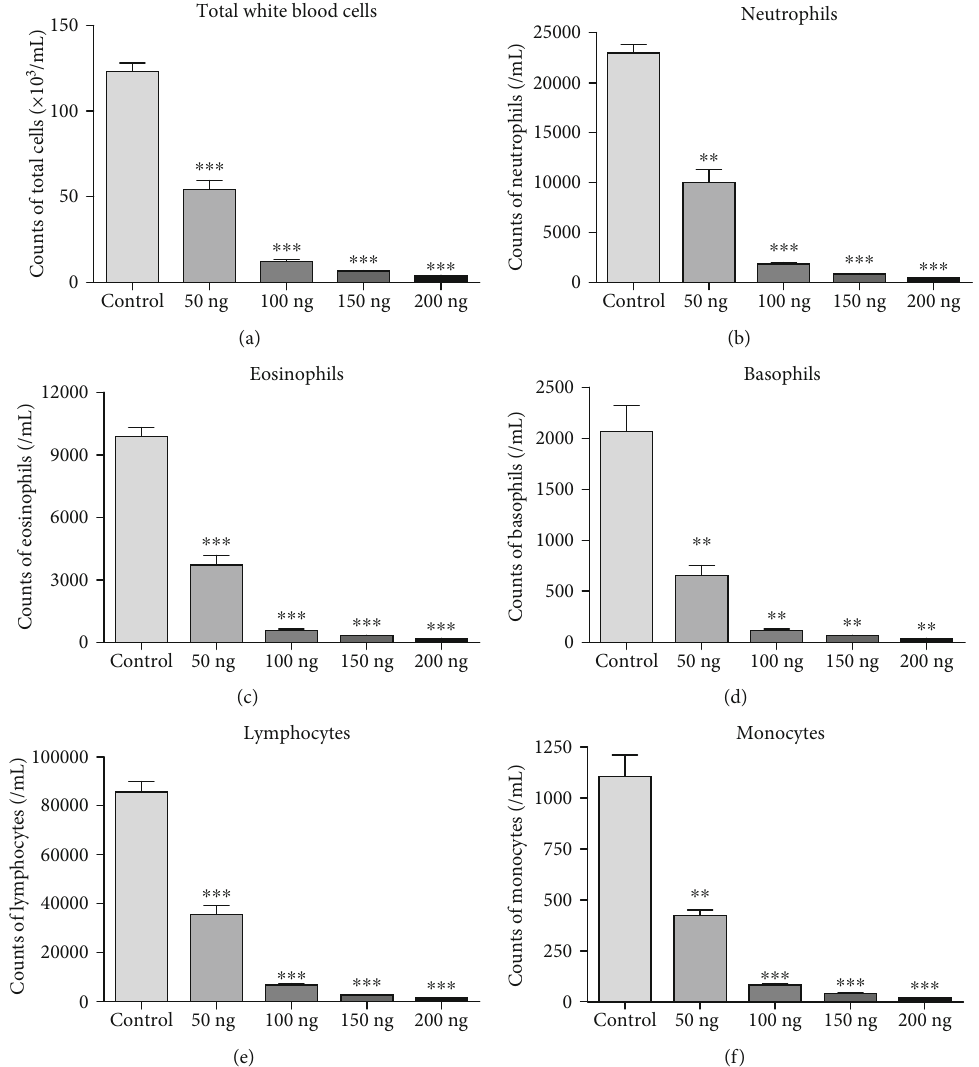
Figure 2: Immune cells were counted in o ff spring mice from VD3-treated group: (a) total white blood cells, (b) neutrophils, (c) eosinophils, (d) basophils, (e) lymphocytes, and (f) monocytes were counted by mouse cell count machine from peripheral blood of o ff spring mice. ∗ P < 0 : 05 VD3 treatment vs. control; ∗∗ P < 0 : 01 VD3 treatment vs. control; ∗∗∗ P < 0 : 001 VD3 treatment vs.